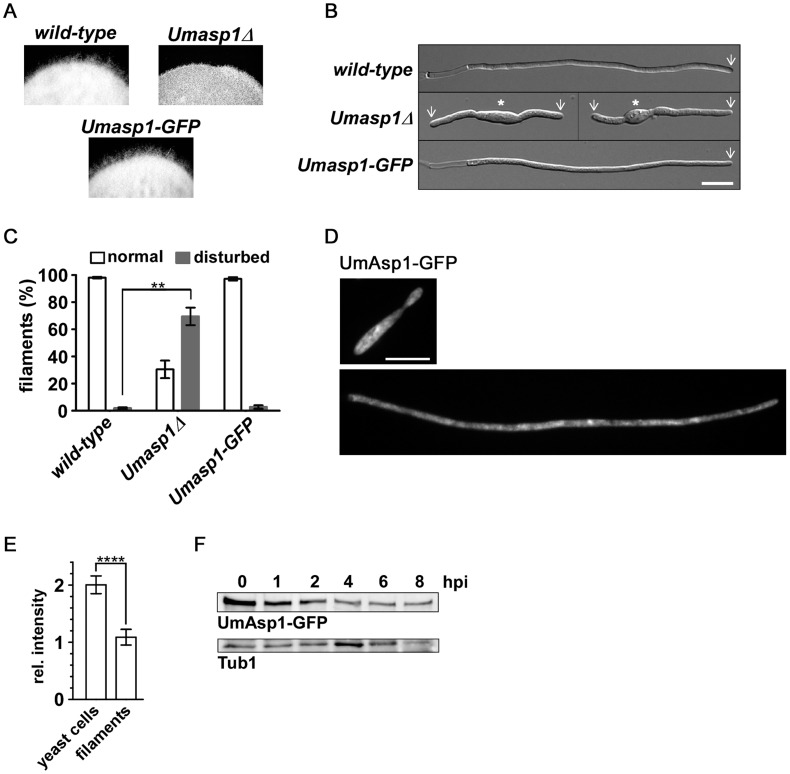
Loss of UmAsp1 causes defects in filamentous growth.(A) Edges of colonies of the indicated AB33 derived strains grown on charcoal plates. Aerial hyphae are emanating from the colony. (B) Photomicrographs (DIC) of the indicated strains grown for 8 hrs under filament inducing conditions. Wild-type and UmAsp1-GFP filaments form characteristic empty sections at the basal pole. White arrow: growth zone; white star: yeast cell (bar, 10 µm). (C) Bar diagram showing percentage of filaments exhibiting normal or disturbed growth. Bars show the mean of three independent experiments with n>100 cells (error bar, SEM; ** p = 0.0108). (D) Examples of UmAsp1-GFP yeast cells and filaments (8 hours post induction) (bar, 10 µm). (E) Bar chart showing mean average fluorescence intensity of UmAsp1-GFP in yeast and hyphae (yeast, n = 10 cells and hyphae, n = 7 cells; see Figure S11 for example photomicrographs). Error bars indicate standard deviation (*** p<0.001 unpaired t-test). (F) Western blot analysis of protein extracts of strain AB33 Umasp1-GFP after induction (0–8 hrs) of filamentous growth. Tub1 served as a loading control (hpi, hours post induction).